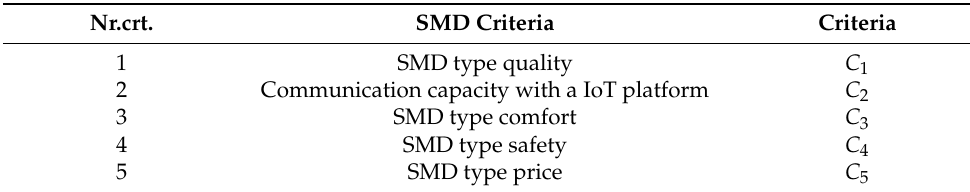
Table 1. The SMD criteria and symbols.